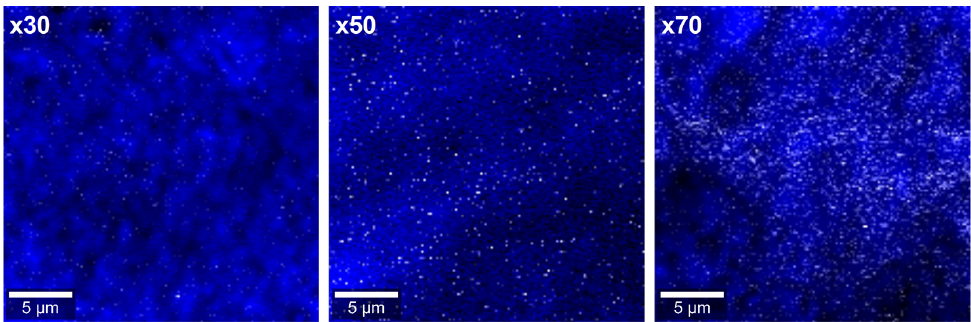
Figure 2. microRaman imaging for ×30, ×50 and ×70 nanocompostites.